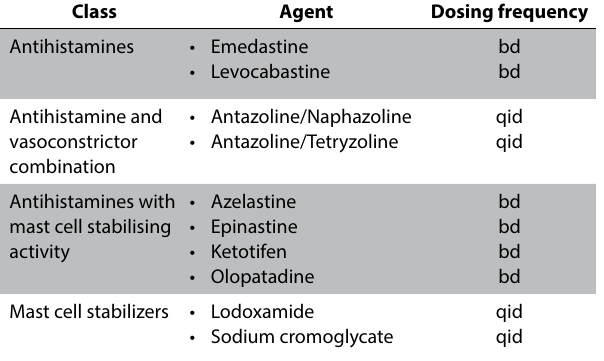
Table 3: Pharmacotherapy guide in treating allergic conjunctivitis 21,27-33 Class Agent Dosing frequency Antihistamines